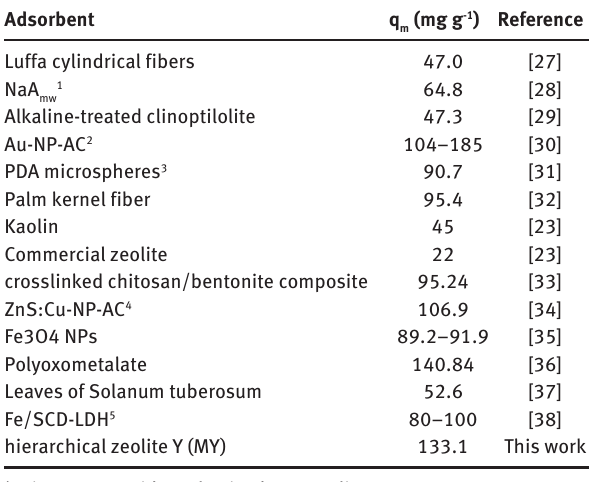
Table 4: Comparison between maximum adsorption capacities (q of various adsorbents in removal of